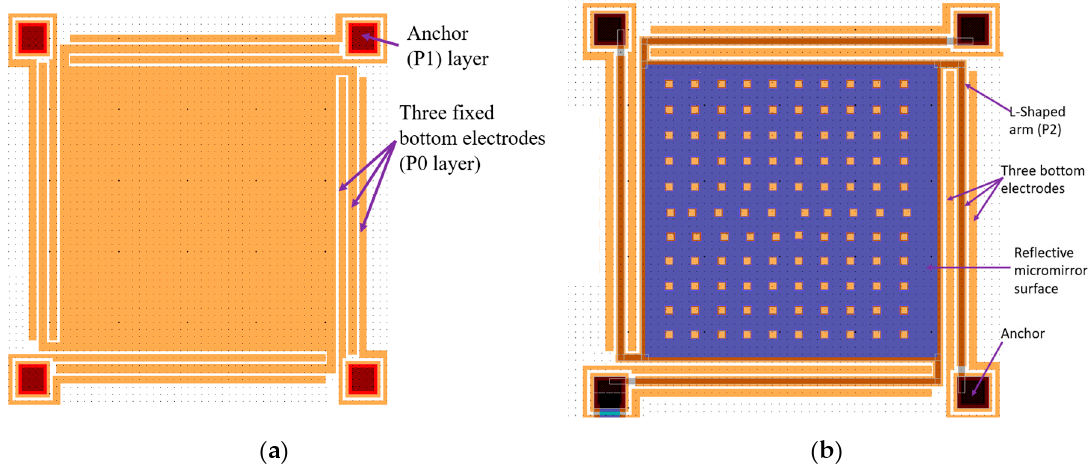
Figure 6. ( a ) Top view of the P0 and P1 designed layers and ( b ) the added P2 and Metal layers for the proposed micromirror in MEMSPro, using PolyMUMPs fabrication process.